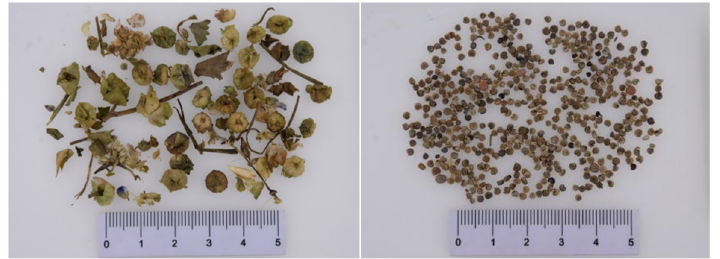
Figure 1. Pictures of Fructus Malvae .